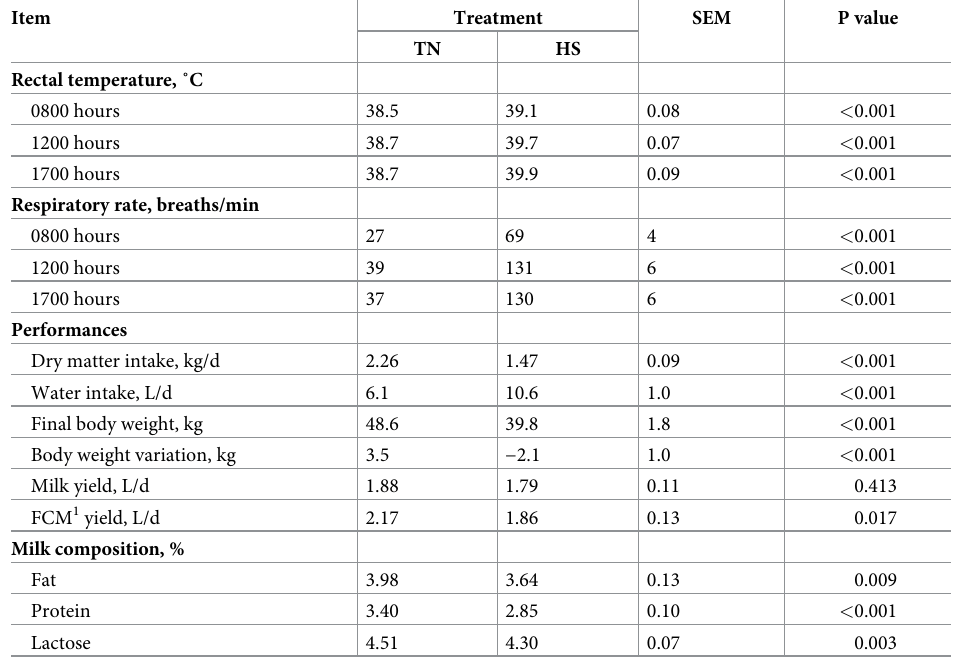
Table 1. Thermophysiological and lactational performances of dairy goats under thermal neutral (TN) and heat stress (HS) conditions. Values are least square means and standard error of the means (SEM).